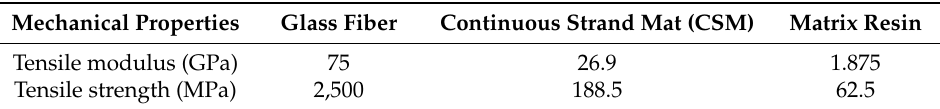
Table 2. Mechanical properties of each layer of the specimens.